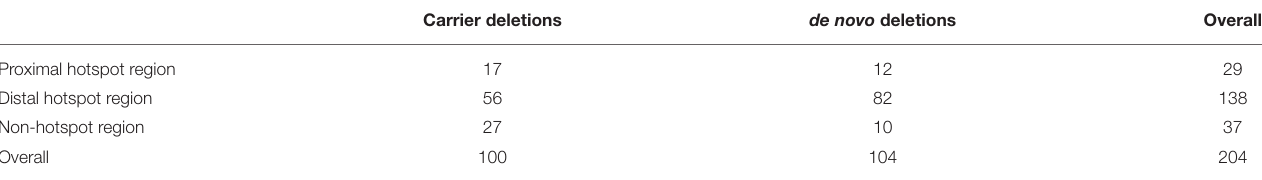
TABLE 1 | Number of patients with DMD who had deletions located in the proximal, distal hotspot region and non-hotspot region. Carrier